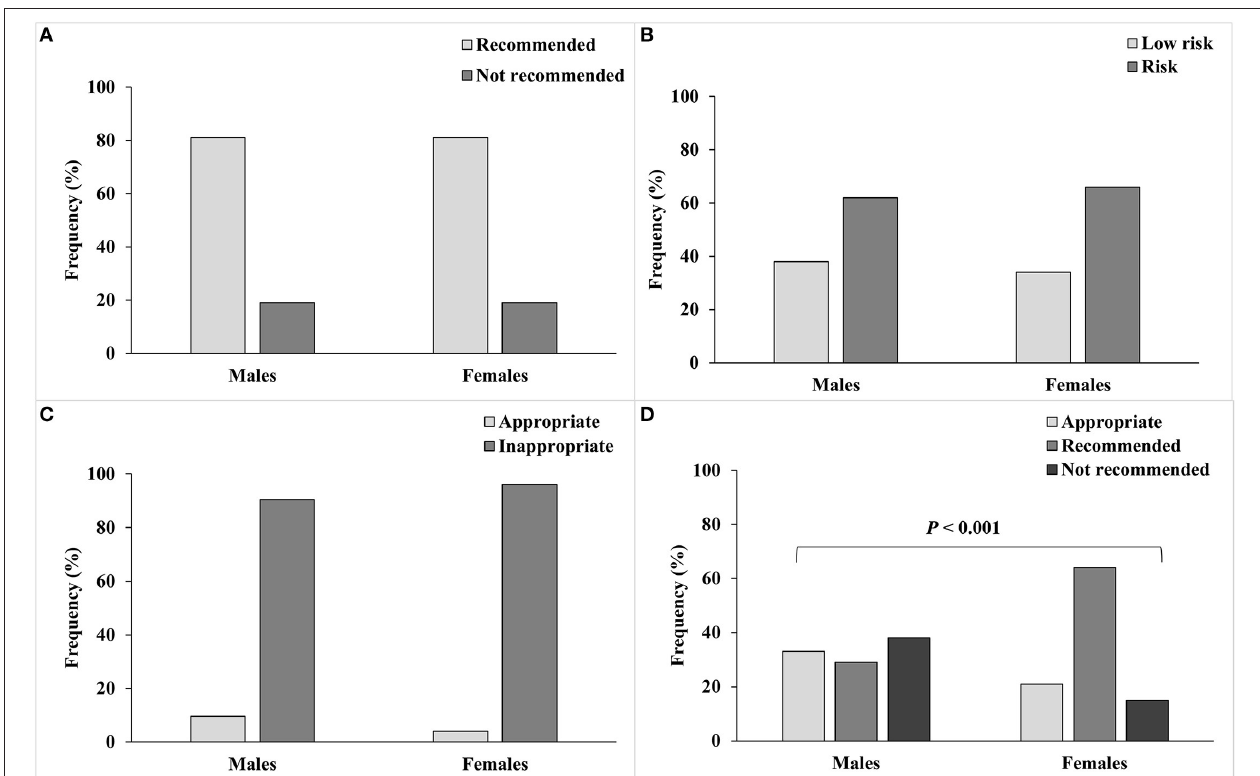
FIGURE 1 | Lifestyle behaviors of male and female college students and their classification according to reference recommendations. (A) Physical activity; 150min of moderate intensity or 75min of vigorous intensity activities, or an equivalent combination is recommended, (B) Hours sitting; sitting ≤ 4h per day was considered low risk, (C) Screen use; screen time of ≤ 2h per day was considered appropriate, and (D) Sleeping hours; 7–9h of sleep is recommended, and 6 or 10–11h of sleep is appropriate.